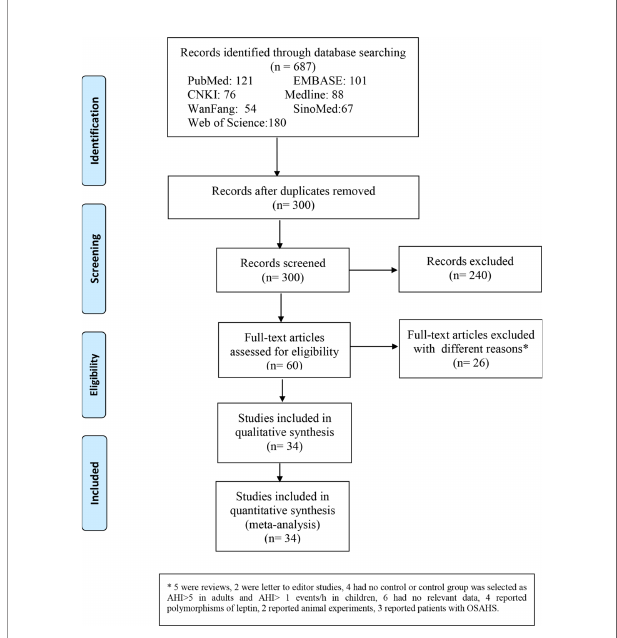
FIGURE 1 | Flow diagram indicating the literature selection process and results based on the preferred reporting items for